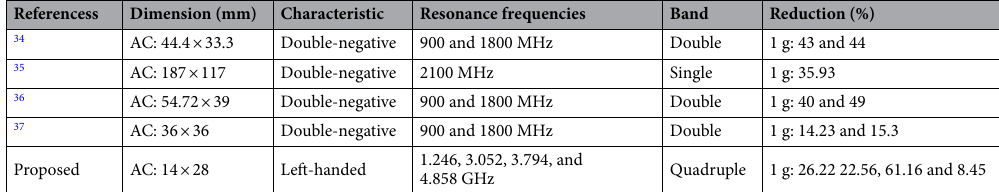
Table 13. A comparison between proposed metamaterial design and previous